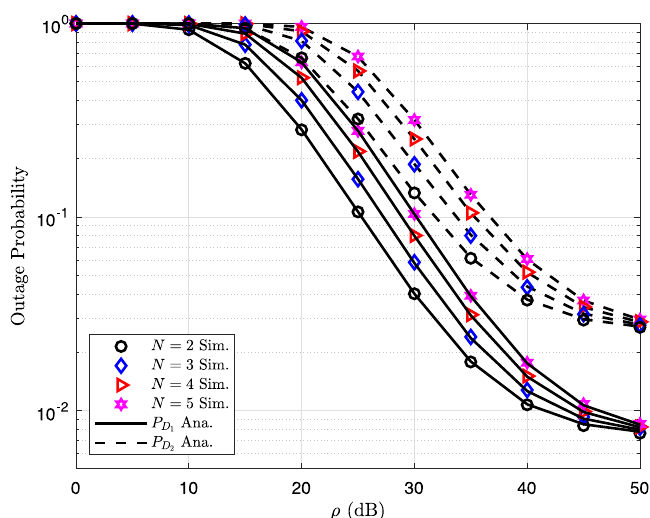
Fig. 5 Outage performance vs ρ (dB) varying N with the satellite link under HS